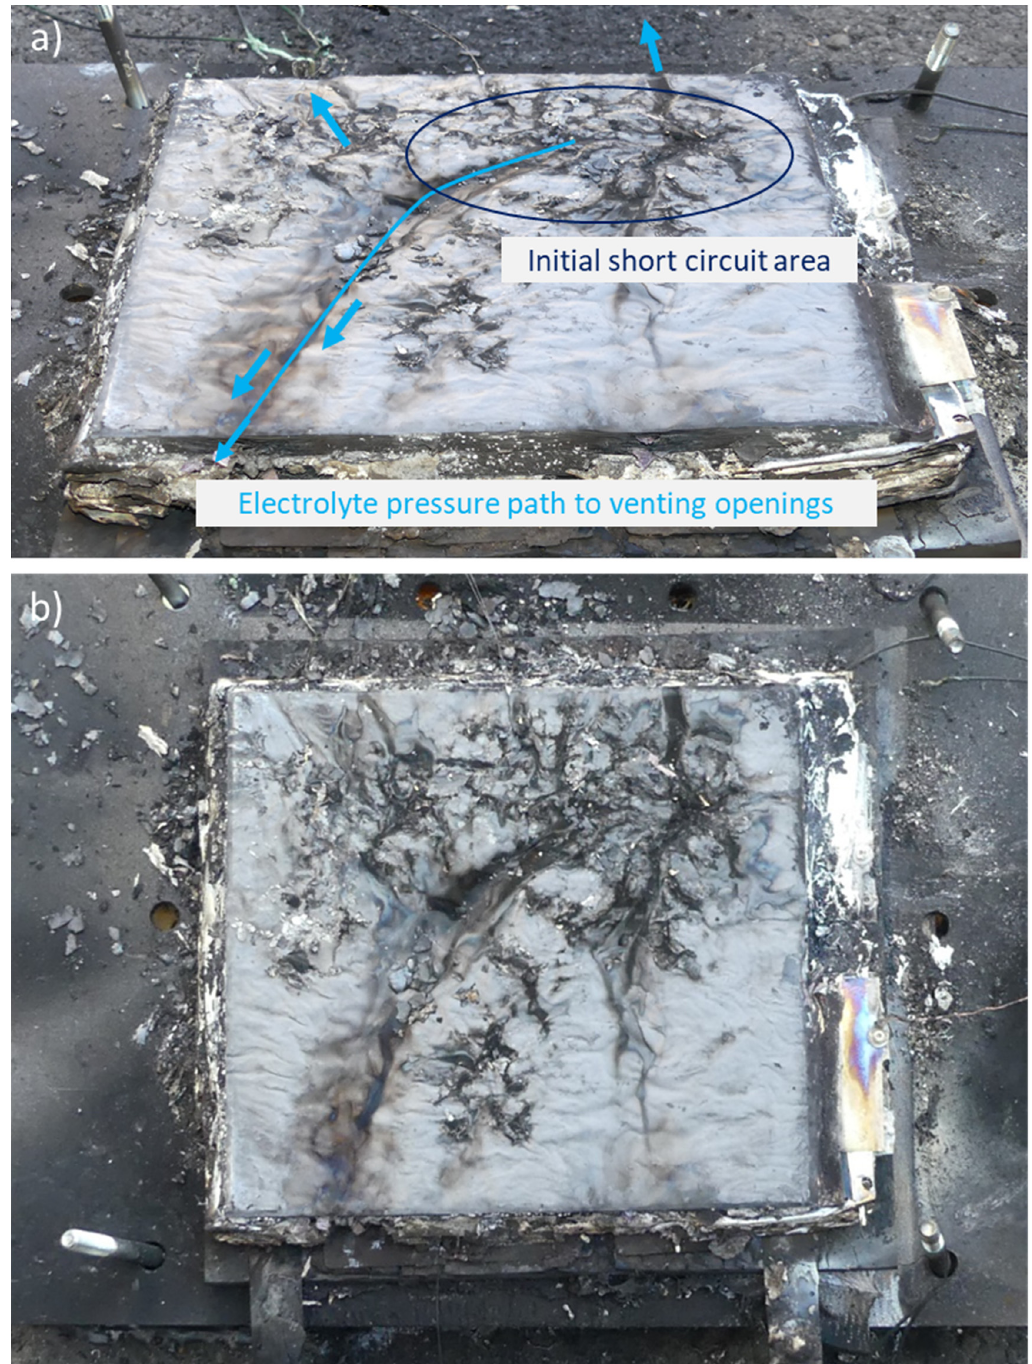
Figure 10. Inspection of battery module after test completion ( a ) Perspective view ( b ) Top view. Traces of burned material on the path of internal short circuit and high temperature electrolyte are well visible on top layer.